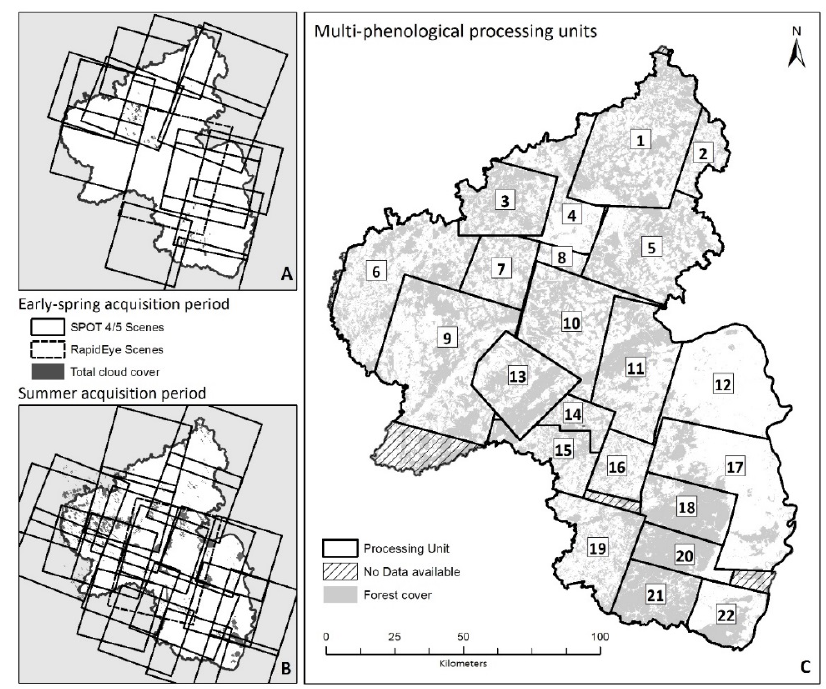
Figure 2. ( a ) Available satellite data for the early-spring acquisition period, representing the phenological stage of foliage development; ( b ) Available satellite data for the summer acquisition period, representing the phenological stage of full foliage; ( c ) Resulting processing